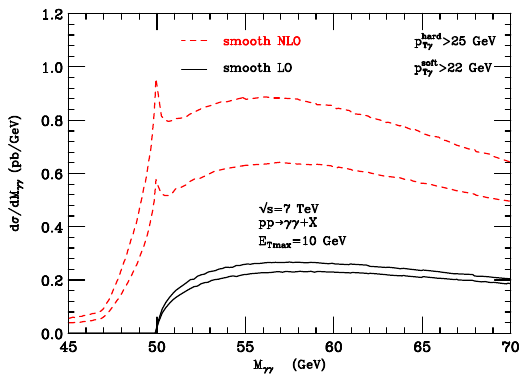
Figure 10 . The differential cross section dσ/dM γγ for smooth isolation with E T max = 10 GeV and the same kinematical cuts as in figure 3. The LO (black solid) and NLO (red dashed) numerical results use M γγ bins with constant size of 0.1 GeV. At both perturbative orders, the maximum and minimum values of dσ/dM γγ correspond to the scale choices µ R = 2 M γγ , µ F = M γγ / 2 , { }